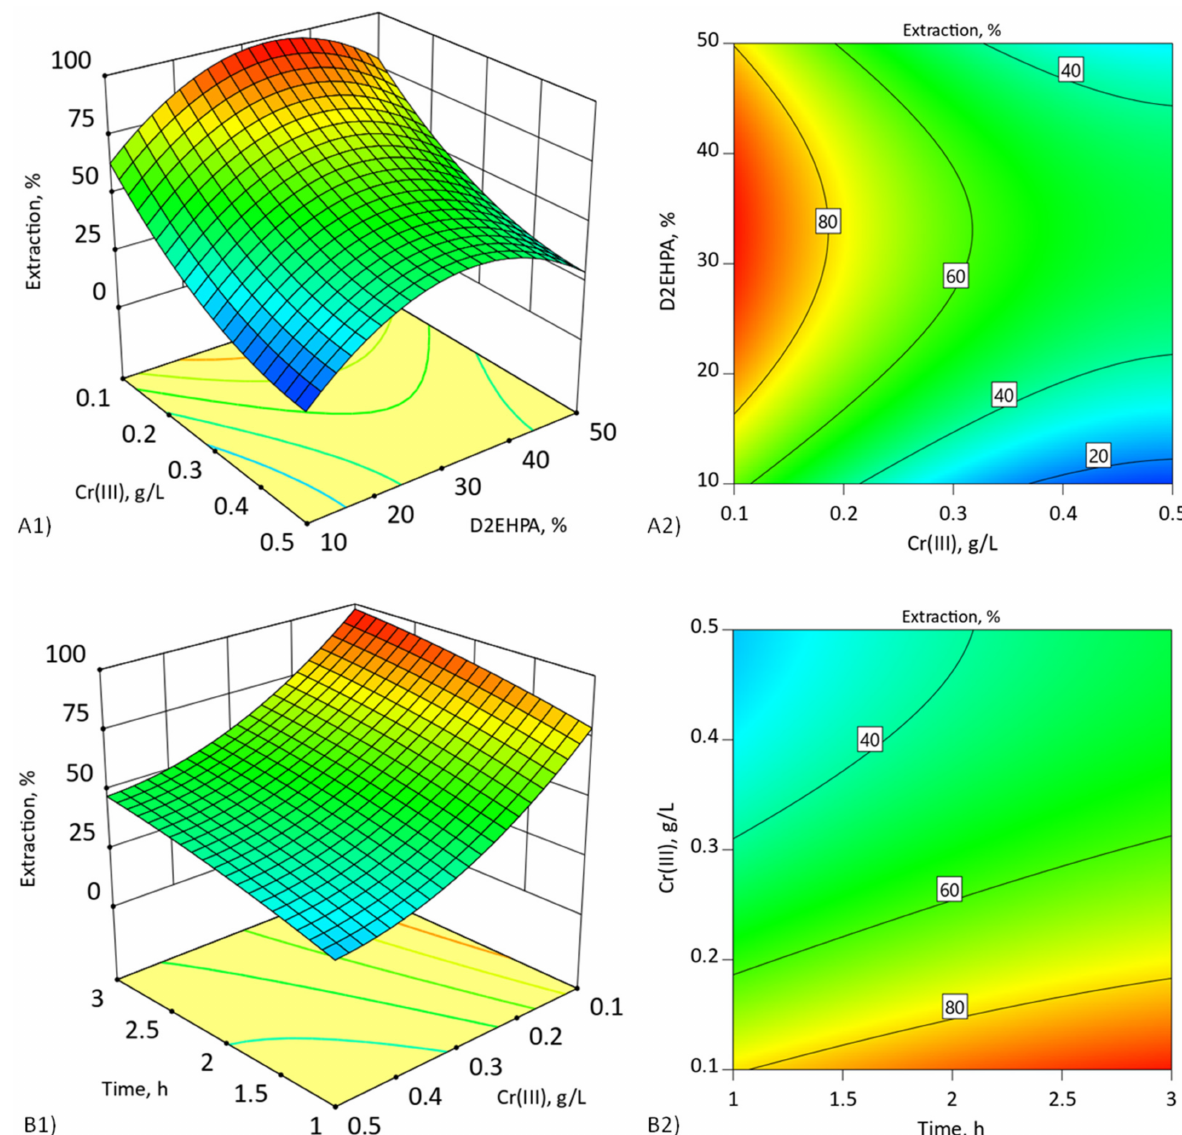
Figure 6. ( A1 , A2 ) Three-dimensional surface plot and contour plot of concentration of D2EHPA% ( v / v ) and chromium(III) (g/L) after 3 h. ( B1 , B2 ) Extraction time (h) and chromium(III) (g/L) for 30% v / v D2EHPA. DCSLM with threshold concentration of